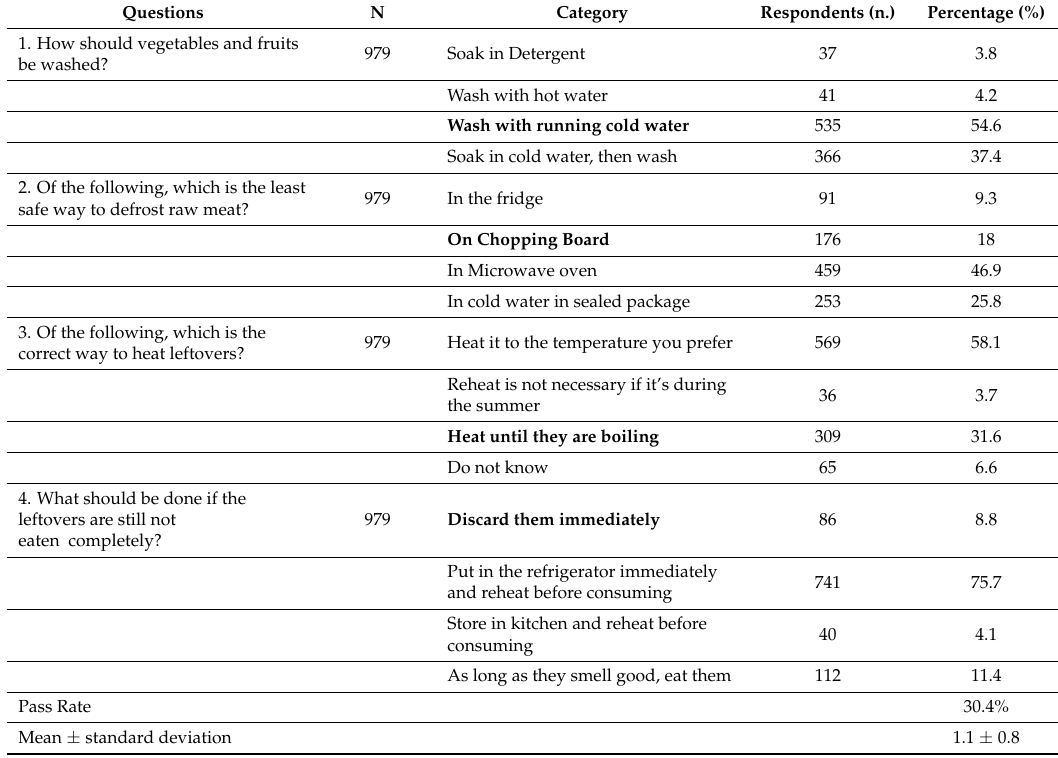
Table 3. Respondents’ knowledge on food handling, pass rate, mean score and standard